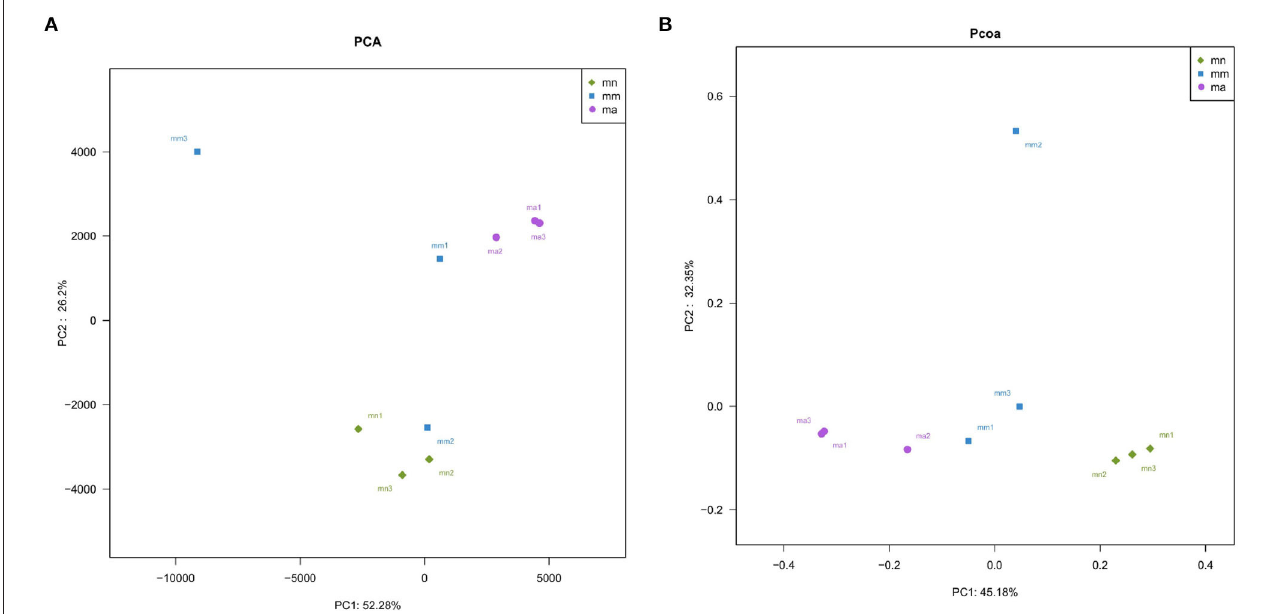
FIGURE 5 | Effect of QWBZP crude polysaccharide on the beta diversity of mice intestinal mucosal bacteria. Green, blue, and purple represent the mn, mm, and ma groups, respectively. Two-dimensional sorting by (A) PCA and (B)